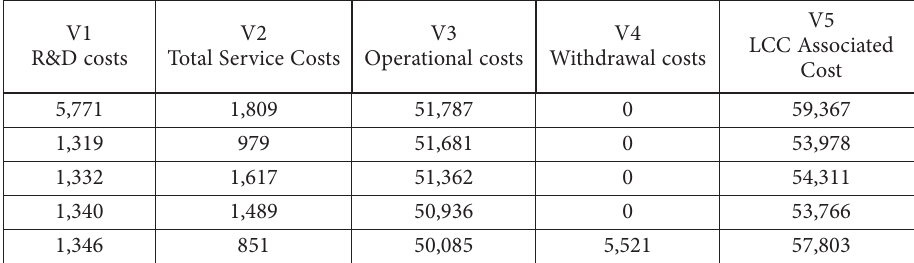
Table 15. Variables of linear regression equations V1 R&D